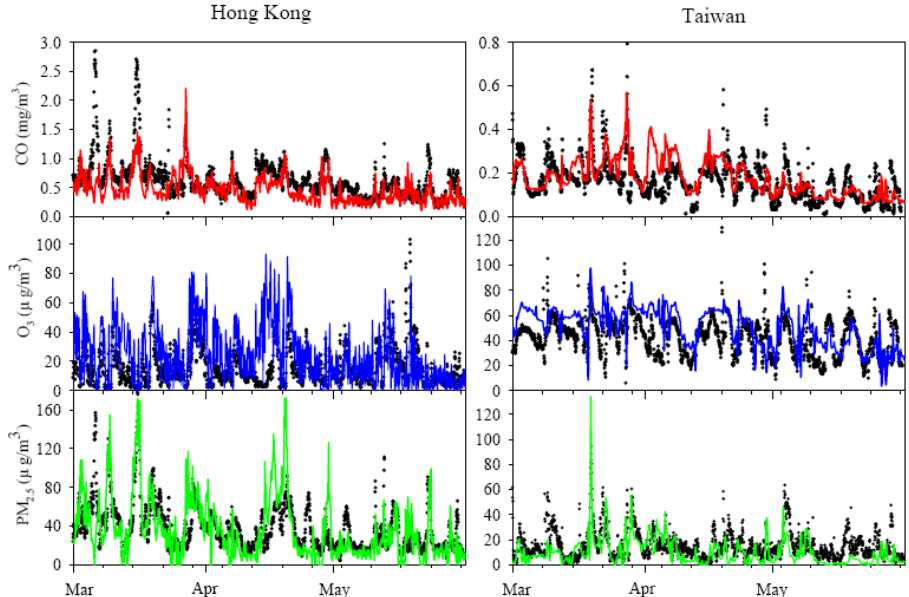
Fig. 3. Time-series of the hourly modeled species concentrations (color lines) and observations (black dots) for CO, O 3 , and PM 2 . 5 in Hong Kong and Taiwan, respectively. The study period covered March, April, and May in 2006. The modeled and observational results in Hong Kong were averaged from 4 monitoring sites, i.e. Tsuen Wan, Yuen Long, Tap Mun and Tung Chung.